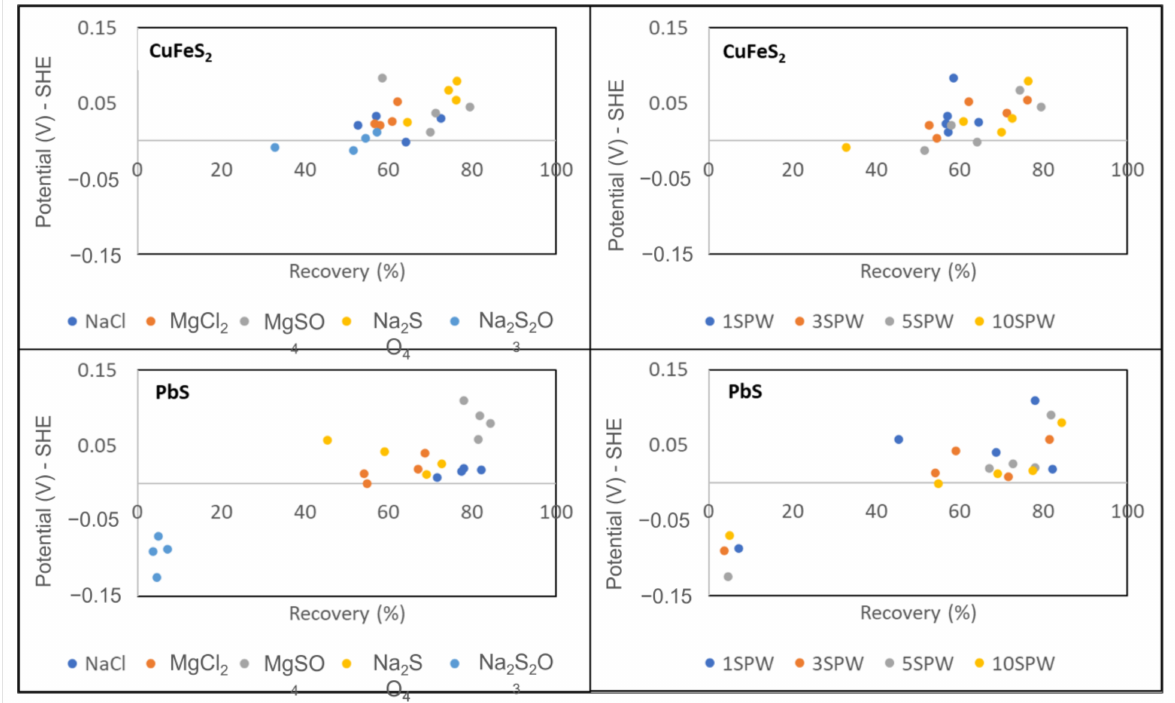
Figure 5. Plots of potential difference vs. initial recoveries for chalcopyrite ( top ) and galena ( bottom ) distinguishing between salt type ( left ) and water type ( right